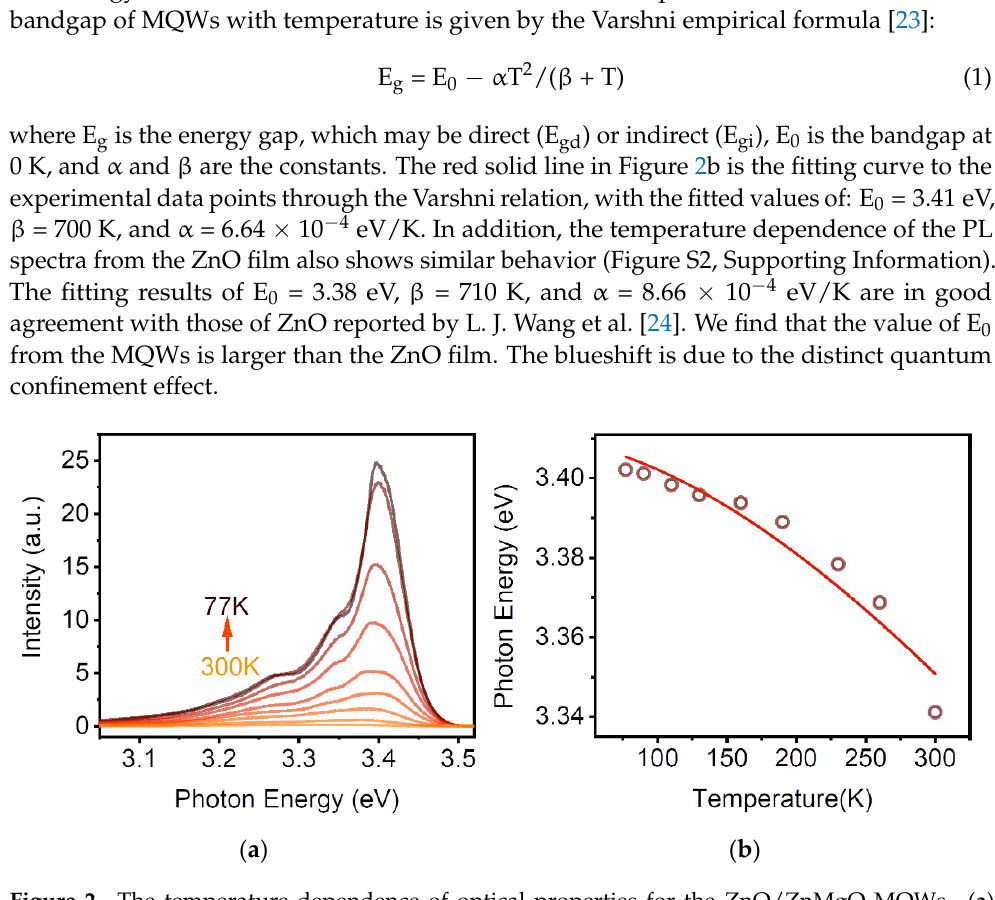
Figure 2. The temperature dependence of optical properties for the ZnO/ZnMgO MQWs. ( a ) Tem- Temperature-dependent PL spectra of the MQWs from 77 K to 300 K. ( b ) PL peak position with perature-dependent PL spectra of the MQWs from 77 to 300 K. ( b ) PL peak position with tempera- temperature for the MQWs. Red solid lines show the fits to the experimental ture for the MQWs. Red solid lines show the fits to the experimental data.